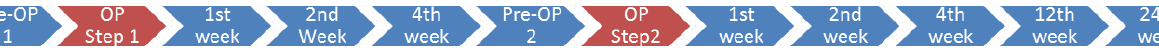
Figure 1. Standard protocol for retrieval of blood samples. Beginning of sampling preoperatively before Step 1 and Step 2 of Masquelet-Technique (Pre-OP 1 and 2) and in further course.